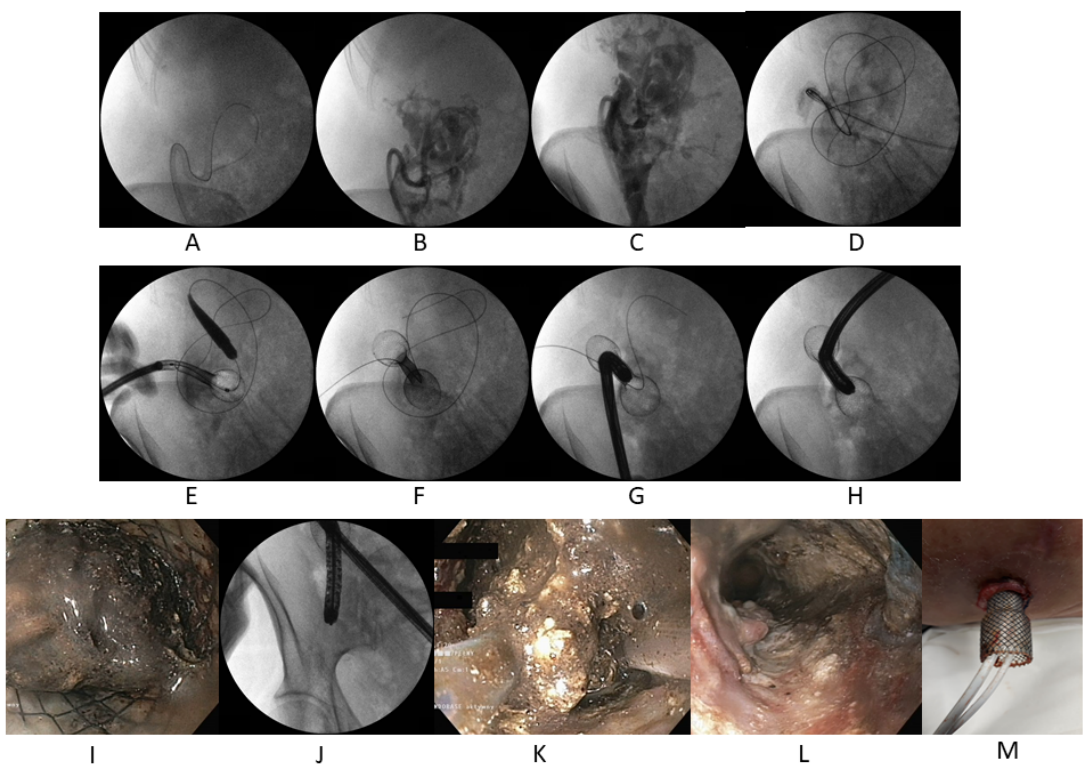
Figure 1. Percutaneous endoscopic necrosectomy in a patient with symptomatic walled-off pancreatic necrosis in the right paracolic gutter and in the right iliac fossa of pelvis. In the fluoroscopy the percutaneous drain ( A ) inside the collection-contrast medium ( B , C ) is visible. The guidewire inserted through the drain was looped in the lumen of the necrotic collection ( D ). Along the guidewire the esophageal self-expanded metal stent was introduced percutaneously ( E , F ). Through the stent the endoscope was inserted to the necrotic cavity ( G – I ) and percutaneous endoscopic necrosectomy was performed ( J – L ). The drains inserted through the percutaneous stent after procedure ( M ).